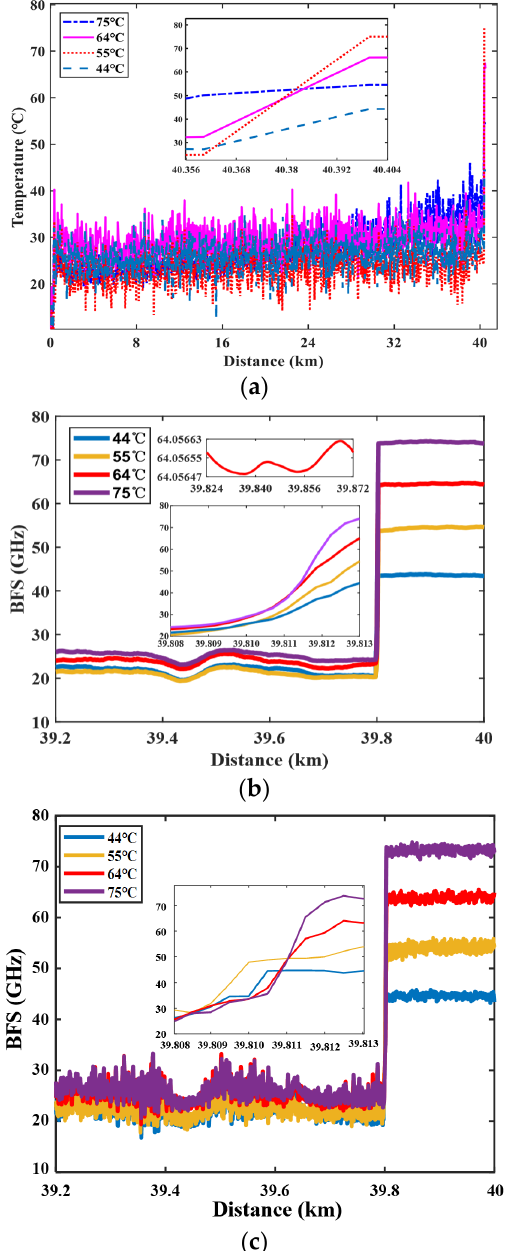
Figure 9. Temperature extracted from raw data, from the FNN with denoising data ( b ) and by the LCF with raw data ( c ).